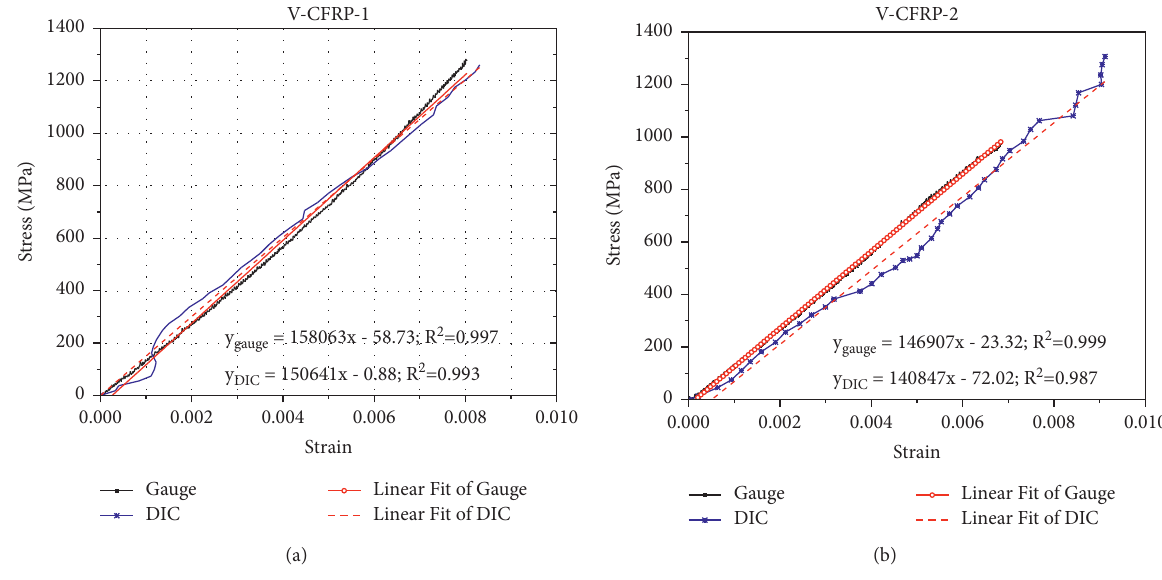
Figure 12: Stress-strain graph of V-CFRP grids. (a) V-CFRP-1. (b) V-CFRP-2. Table 7: Young’s modulus comparison of V-CFRP-1. Table 8: Young’s modulus comparison of